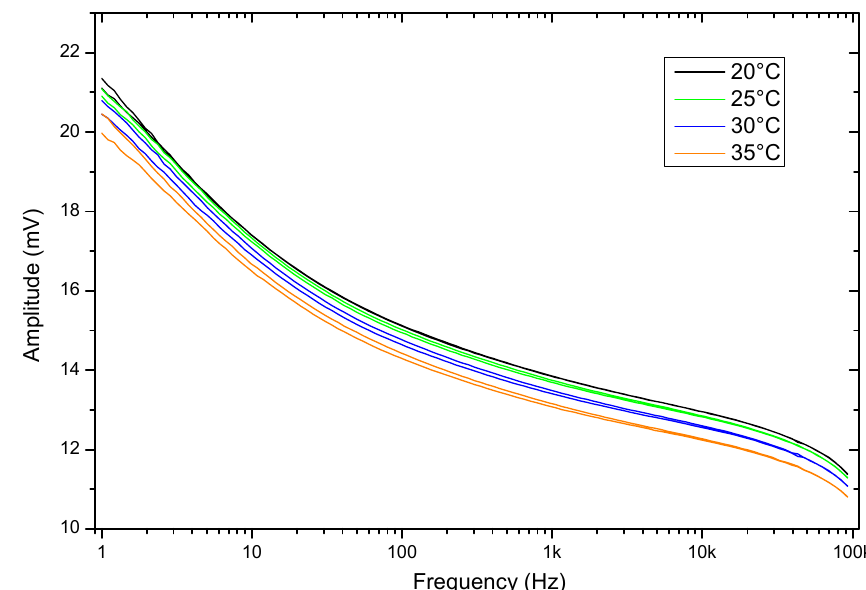
Figure 11. Magnitude results of the sensor response as a function of temperature.